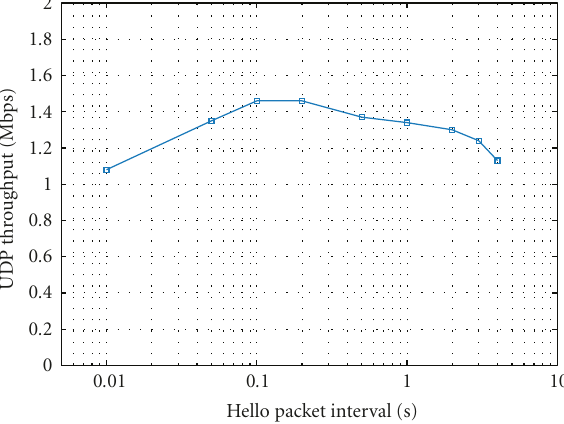
Table 6: Settings for study of end-to-end delay.